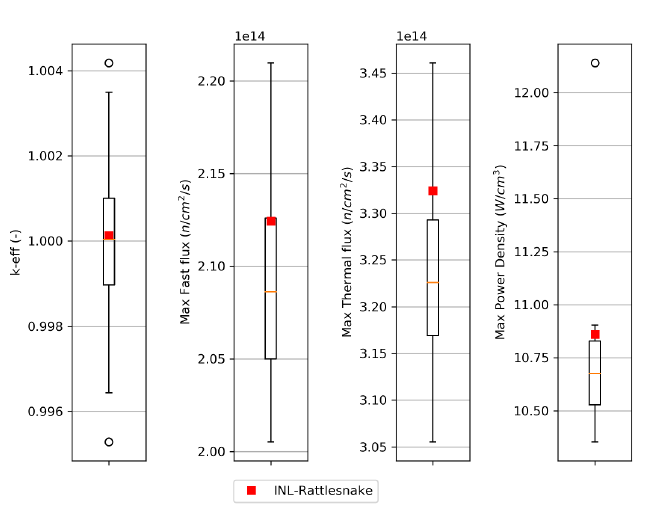
Figure 3: Global Parameter Results Comparison - k-eff, Maximum Fast Flux, Max Thermal Flux, Max Power Density